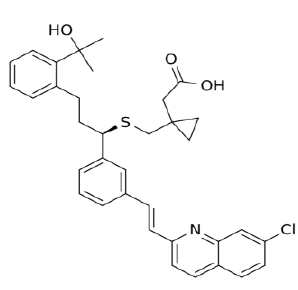
Figure 1. Montelukast chemical structure Licorice Glycyrrhizaglabra, also known as licorice and sweet wood, is derived from the ancient Greek term glykos, meaning sweet, and rhiza, meaning root. A number of components